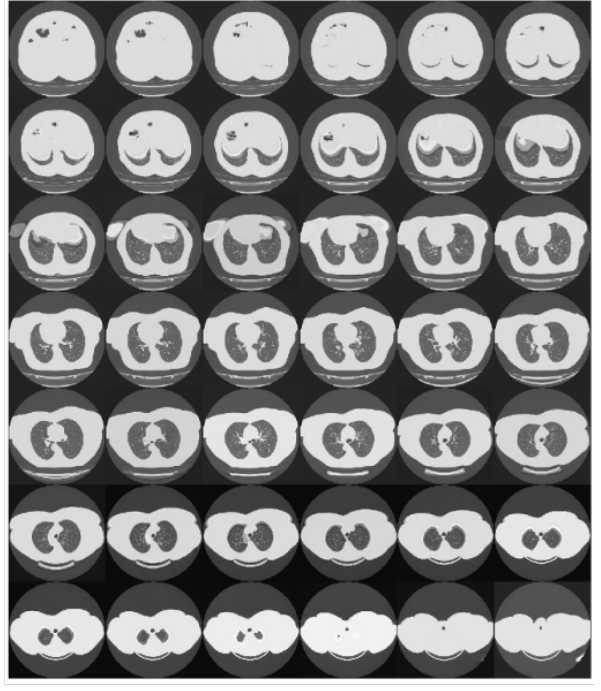
Figure 5. The figure shows the slices of a chest scan. It can be observed that the information content of the scan tends to reduce moving toward its ends.